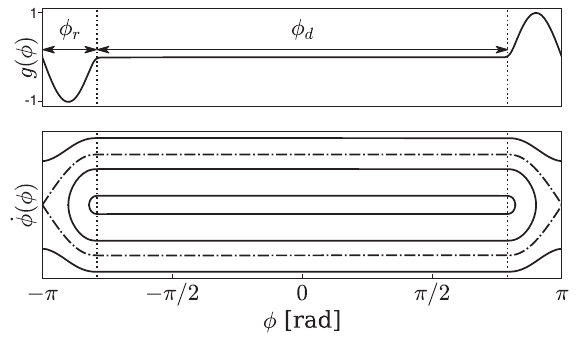
FIG. 1. The rf voltage normalized by the peak amplitude (top) of the pulsed rf system generating a barrier bucket with the reflection region ϕ and drift space ϕ . The bottom plot is the r d illustration of the corresponding trajectories in the longitudinal phase space, including the separatrix (dashed